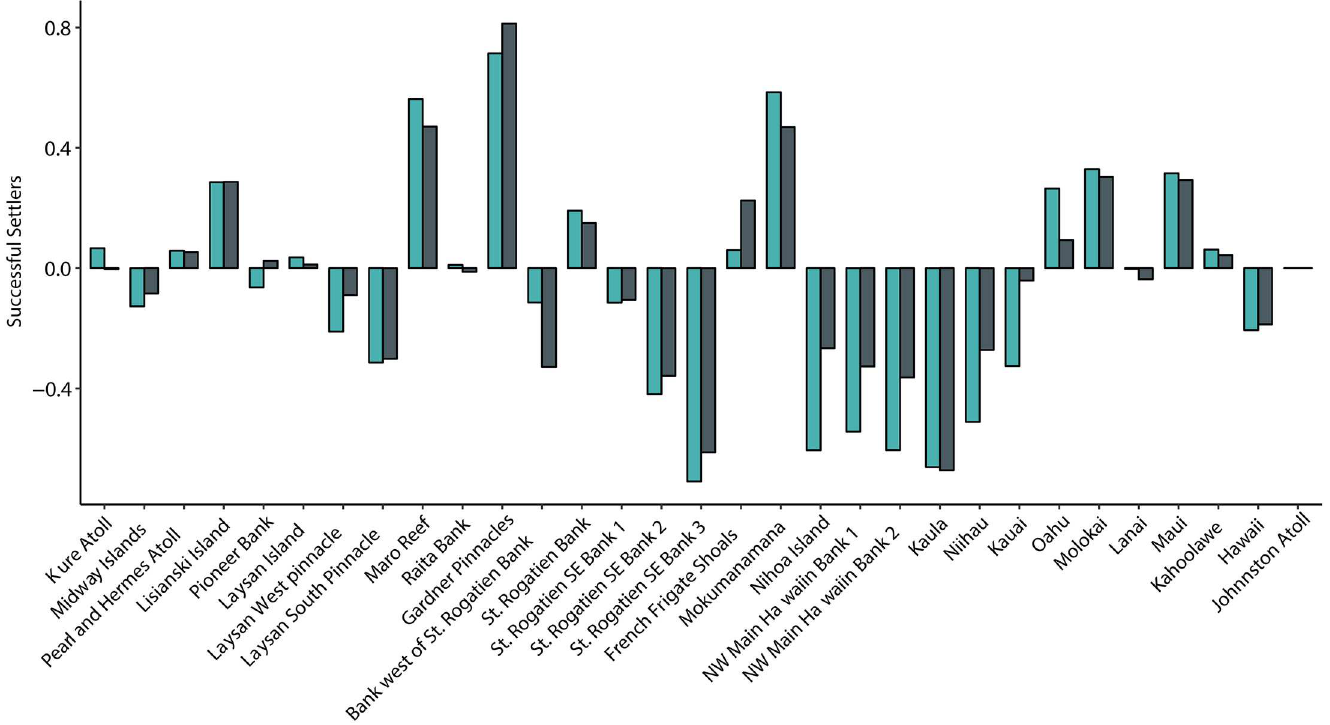
Fig 8. Source-Sink index for all islands in the Hawaiian Archipelago for the 5-yearmodel run. Positive numbers indicatea net source location, and negativenumbersindicate a sink location.Green color denotes particles releasedduringMay-June of each year and gray denotesdistances for year- round